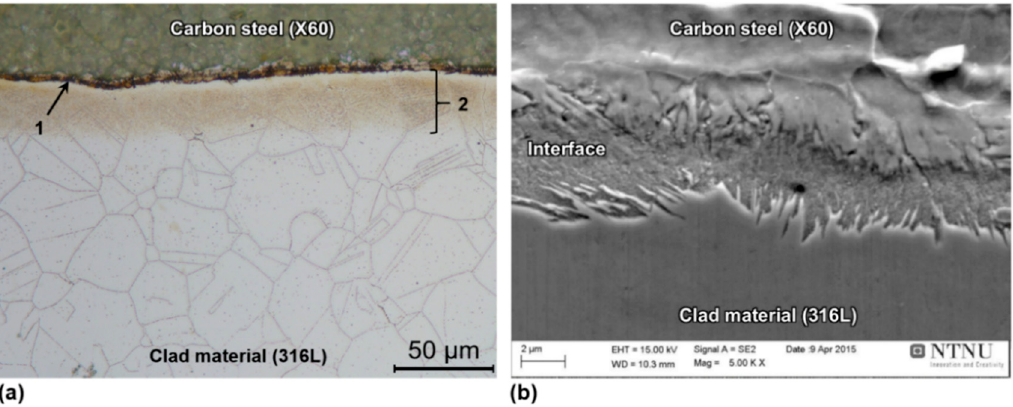
Figure 1 . Carbon steel–clad (316L) interface microstructure as observed by ( a ) optical microscopy and ( b ) SEM; 1—the interface layer and 2—the width of the carbon diffusion layer [18] . ( b ) SEM; 1—the interface layer and 2—the width of the carbon di ff usion layer